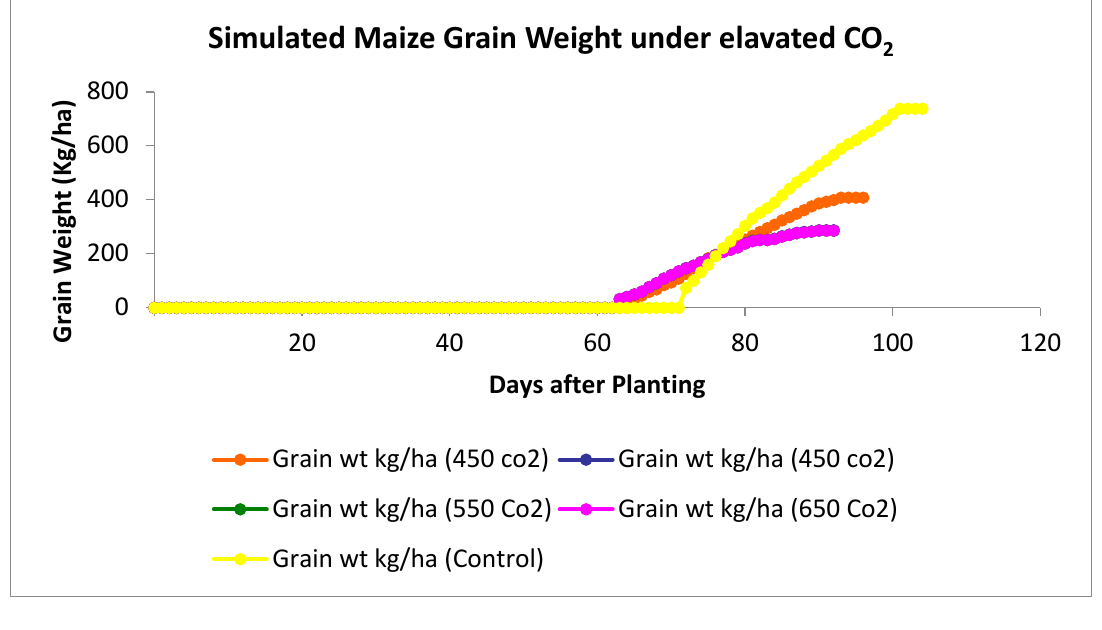
Figure 9. ( a ) Trends in simulated yield; ( b ) box and whiskers plot of observed vs. simulated maize yield in Coimbatore from 1987 to 2016, respectively (Source: Seasonal Crop Report- DoES, Tamil Nadu); ( c ) simulated maize grain weight under elevated CO 2 concentration for the study area.